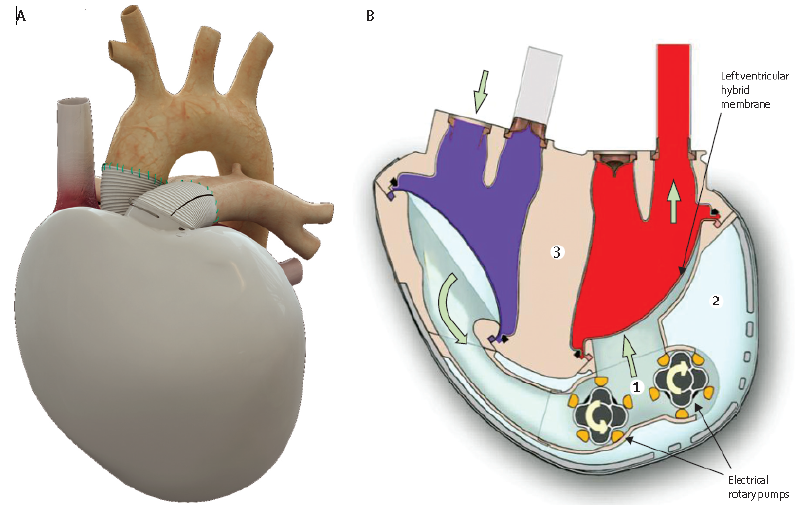
Figure 2: The CARMAT bioprosthetic total artificial heart.